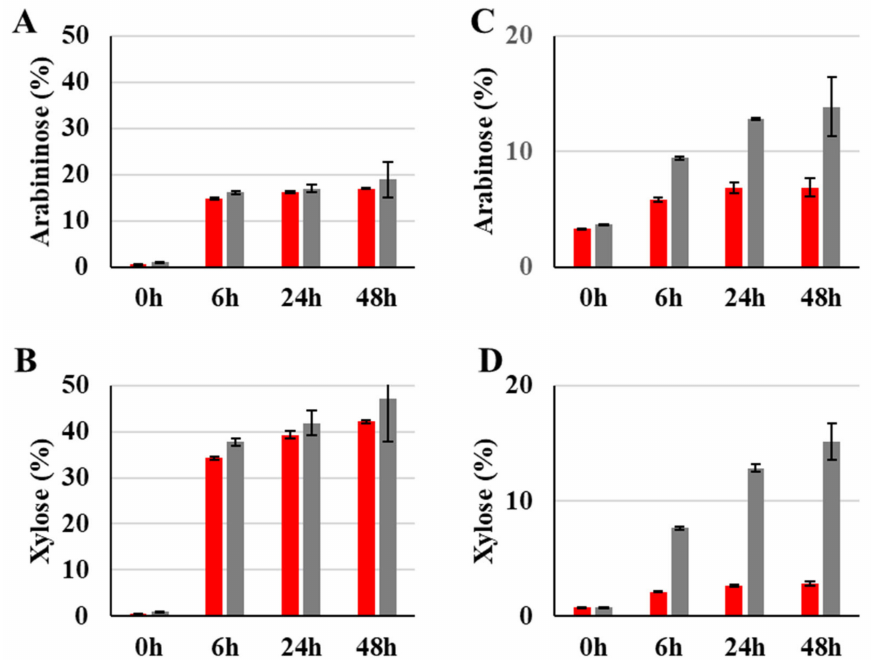
Figure 5. Enzymatic hydrolysis capacity on destarched wheat bran ( A , B ) and wheat straw ( C , D ) of Xyn11-29 xylanase (red bars) compared with T. xylanolyticus xylanase, Tx -Xyn11 (gray bars) after 0, 6, 24, and 48 h incubation at pH 5.5 at 35 ◦ C and at pH 5.8 at 60 ◦ C for Xyn11-29 and Tx-Xyn11, respectively. Results are expressed as a percentage of released sugars (arabinose and xylose). Each data point (mean +/ − standard deviation) is the result of duplicate